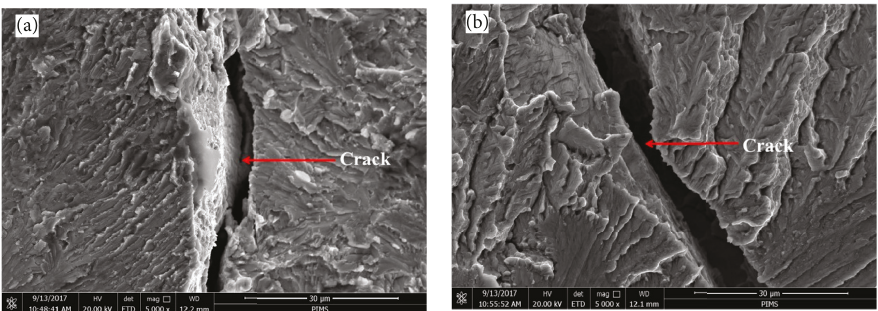
Figure 8: Fracture surface morphologies of welded joints: (a) EBW-1; (b) EBW-2.